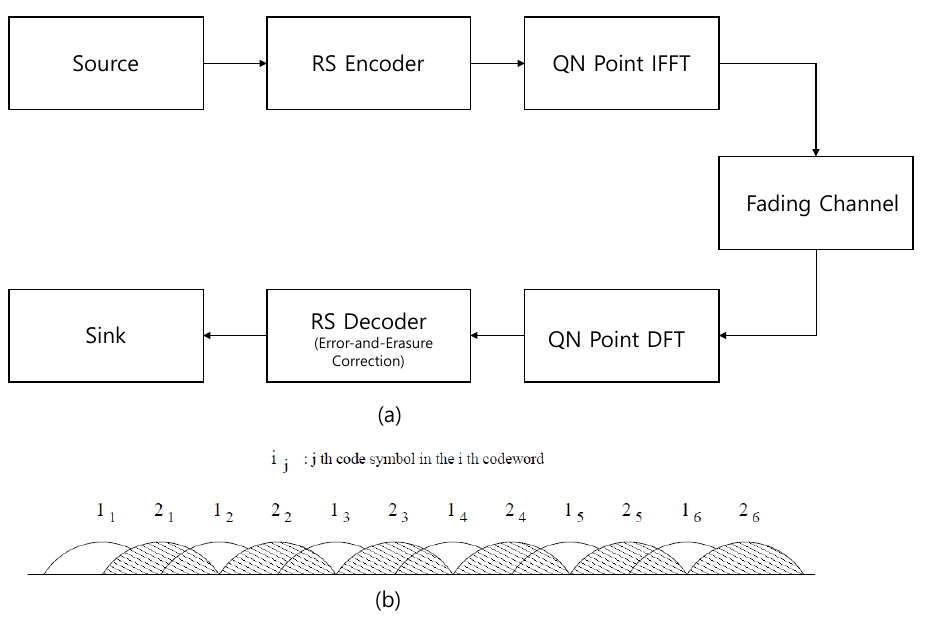
Figure 1. ( a ) Discrete time system model. ( b ) Power spectrum of the transmitted signal ( Q = 2, N =